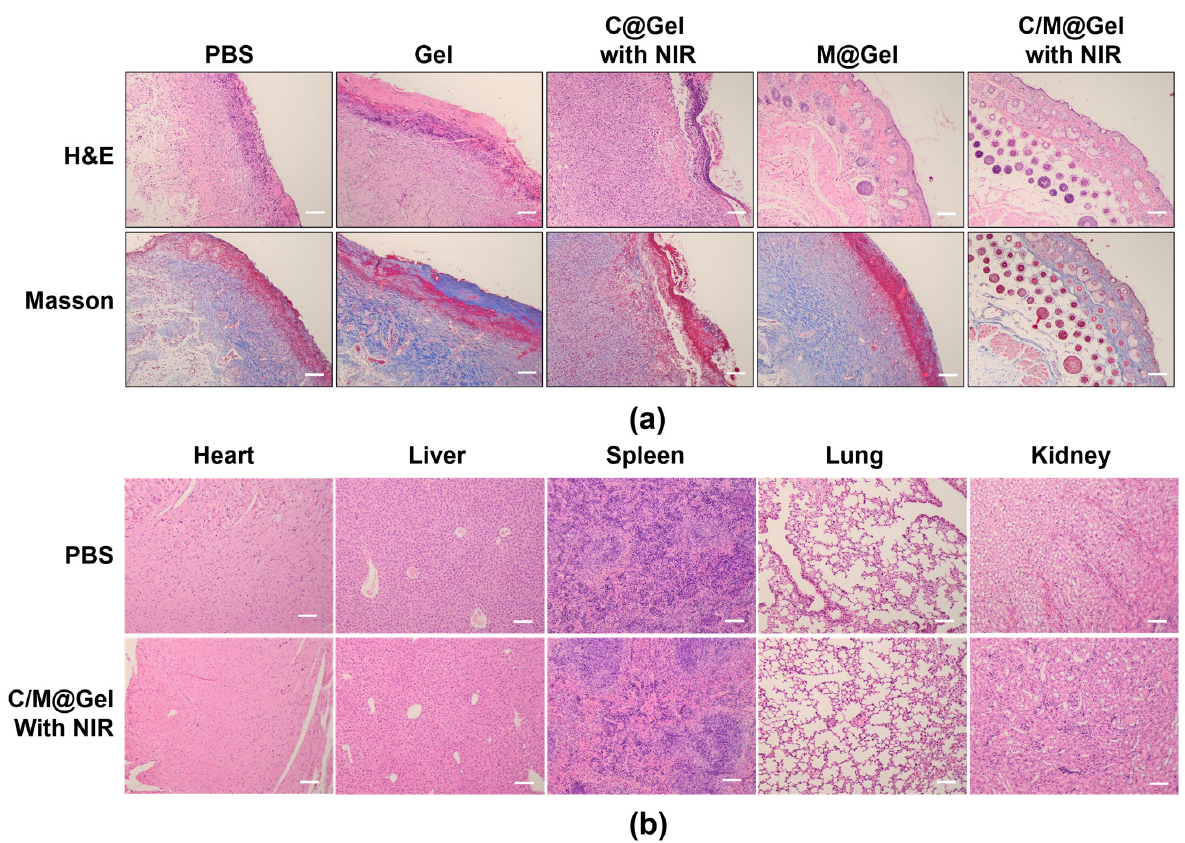
Figure 6. Histological analysis of infected skin and main visceral organs. ( a ) Representative H&E and Masson staining images of the infected skin after different treatments of PBS, Gel, C@Gel with NIR, M@Gel and C/M@Gel with NIR. Scale bars: 100 μ m. ( b ) H&E staining of heart, liver, spleen, lung, and kidney after the treatments in PBS and C/M@Gel with NIR group. Scale bars: 100 μ m.